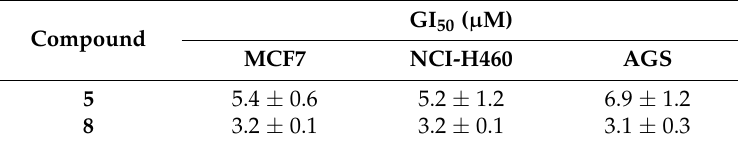
Table 2. GI 50 values of compounds 5 and 8 following 48 h treatment of three human tumor cell